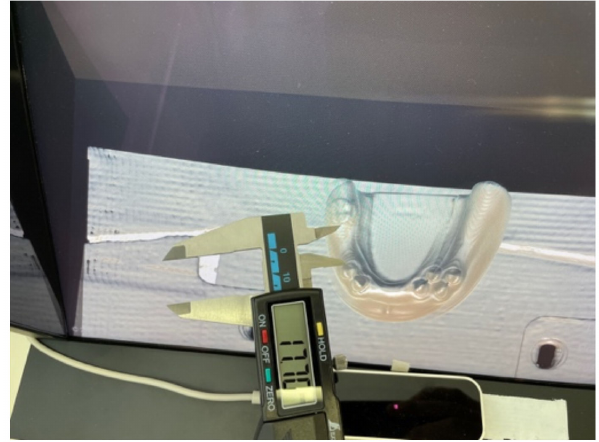
Figure 17. Measurement in the depth